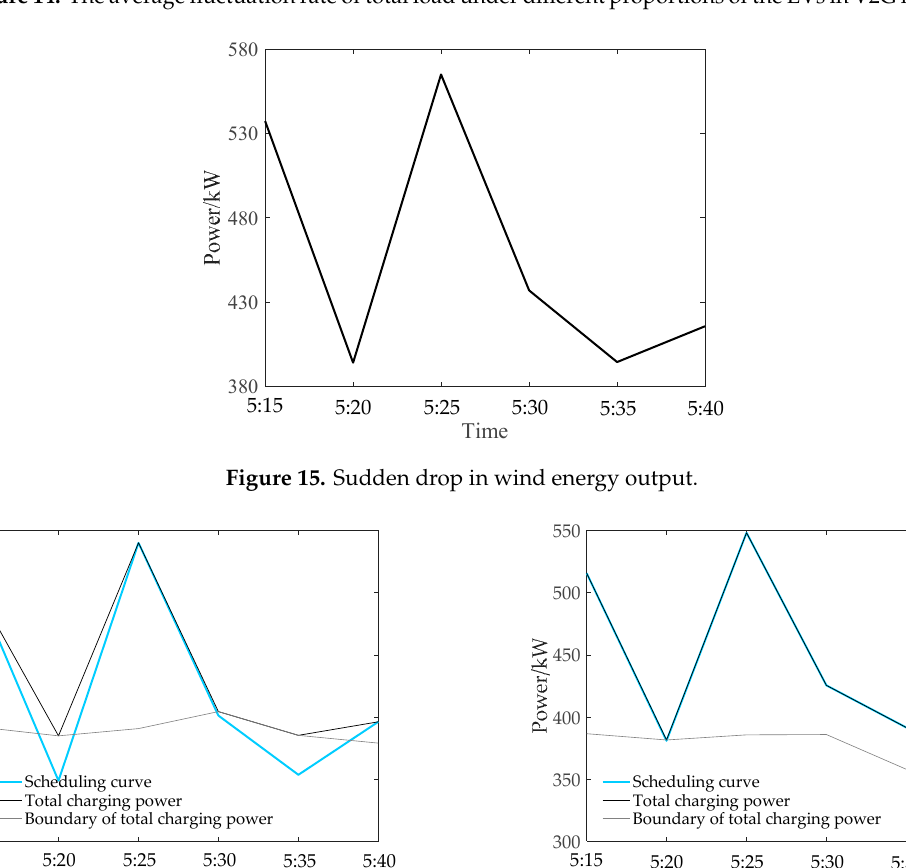
Figure 14. The average fluctuation rate of total load under di ff erent proportions of the EVs in V2G mode.